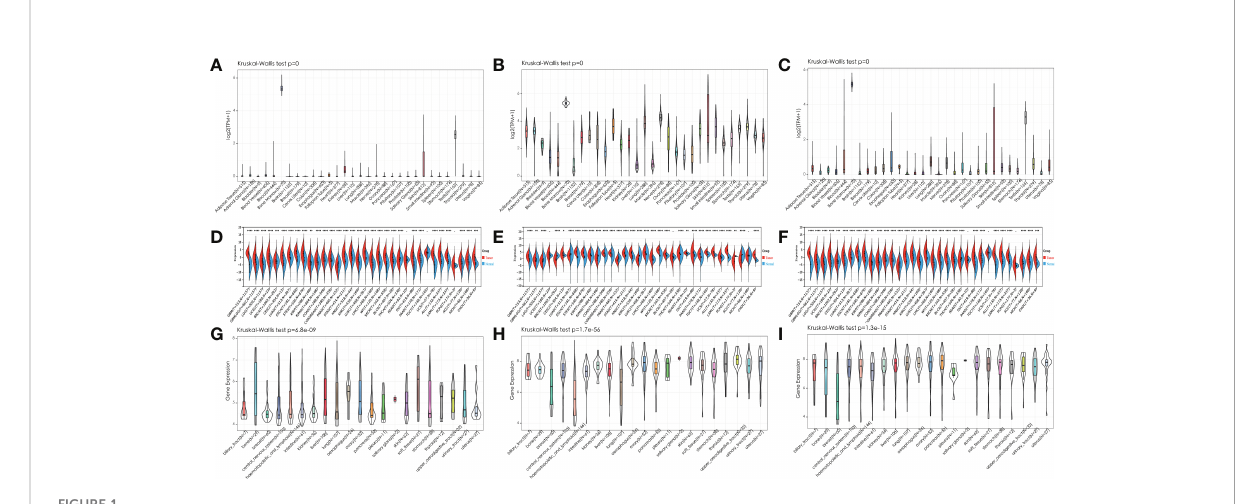
FIGURE 1 Expression pattern of IGF2BPs in human cancers. (A-C) Expression pattern of IGF2BPs in diverse normal tissues (data from GTEx). (D-F) Expression pattern of IGF2BPs in GTEx normal, TCGA normal, and TCGA cancer tissues. (G-I) Expression pattern of IGF2BPs in diverse cancer cells (data from CCLE). *P < 0.05, **P < 0.01, ***P < 0.001, ****P <